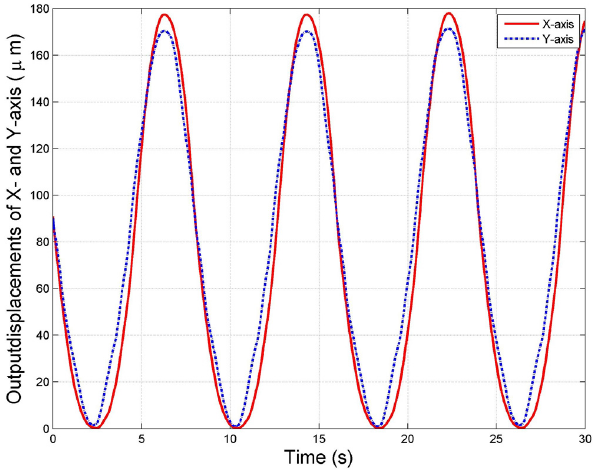
Figure 16. The output displacements of x - and y -axes.